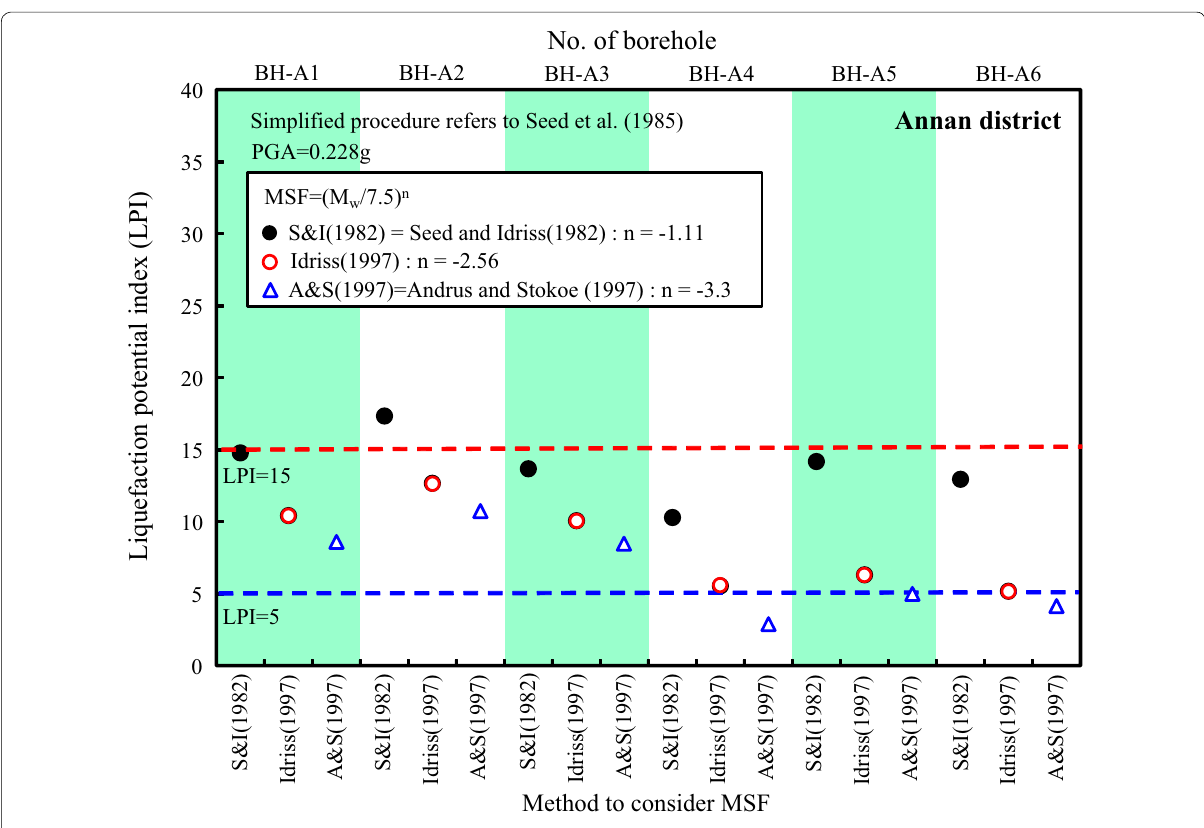
Fig. 7 Evaluated LPIs for the Annan District with considering different